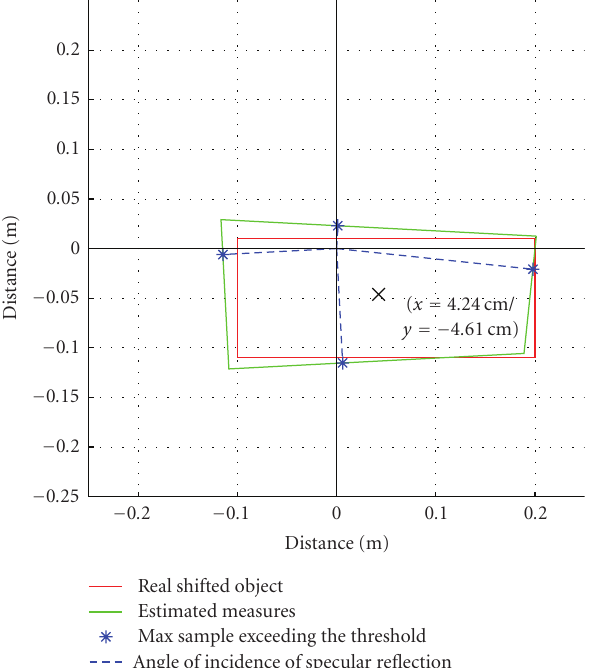
Figure 11: Estimated surrounding boundary and local